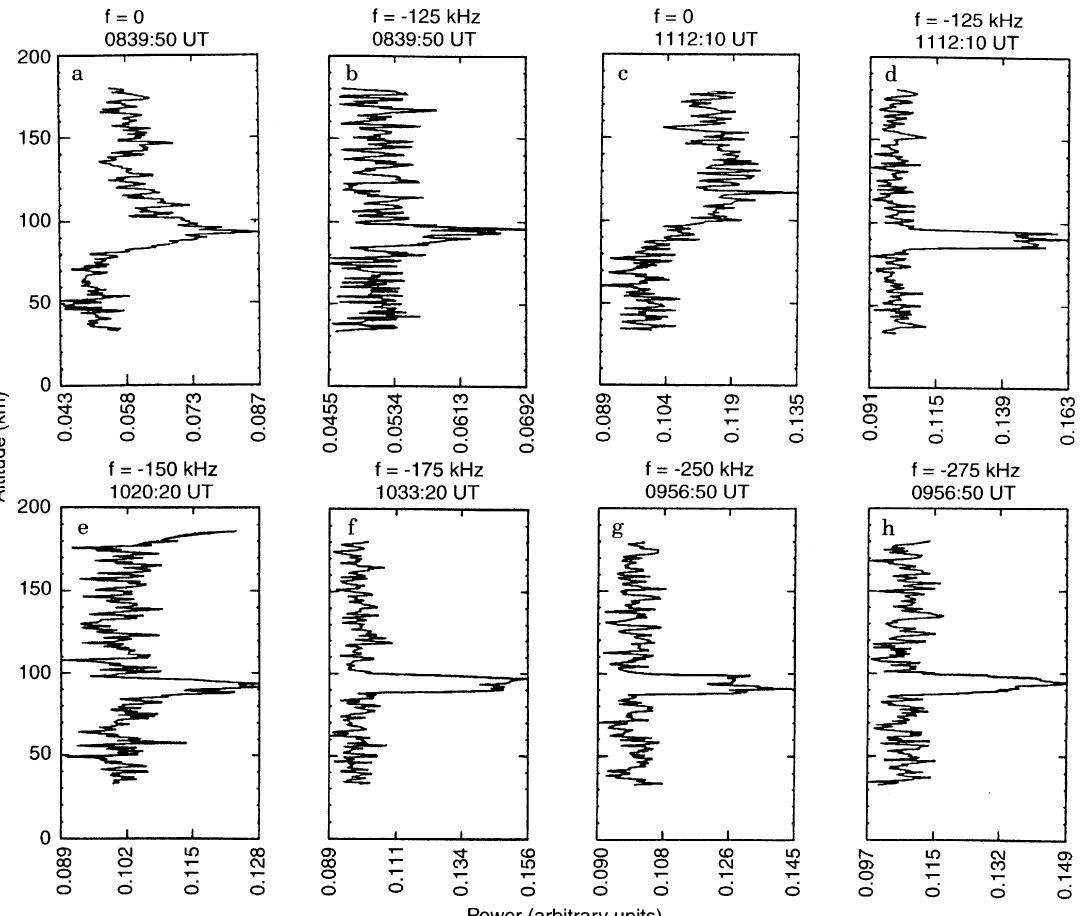
at f "! 150, ! 175, ! 250 and ! 275 kHz. Integration time is 10 s in all panels. The power is in arbitrary units